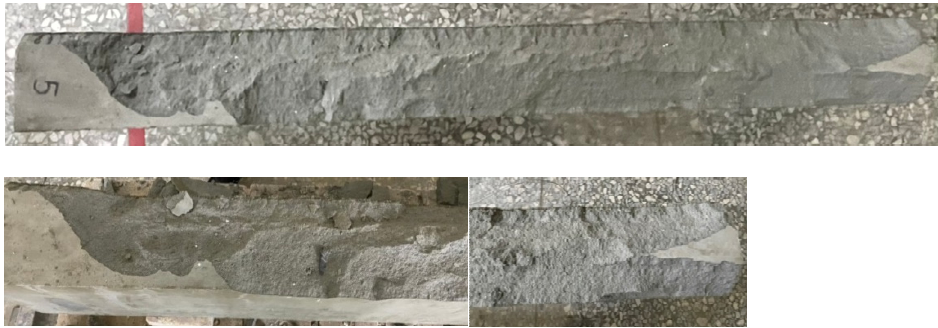
Figure 8. The spalled surface of the HSC beam specimen after being subjected to 500 °C.